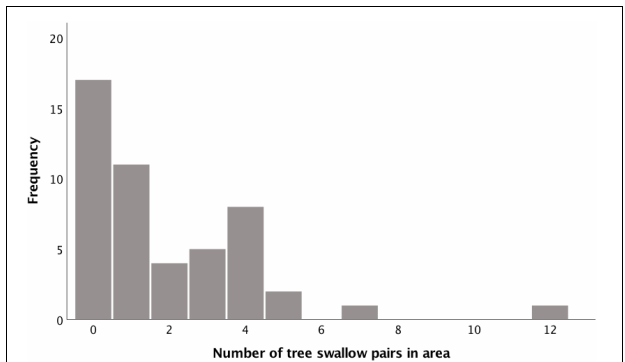
FIGURE 1 | Distribution of the number of active tree swallow nests within the 75 m 2 territory of breeding eastern bluebirds. Low density is designated as 0 or 1 tree swallow nest while high density is designated as 2 or more tree swallow